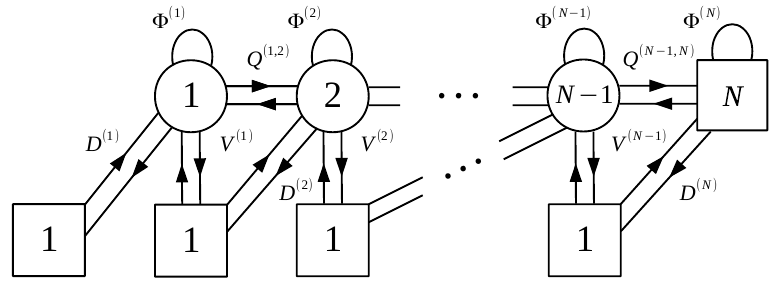
Figure 2 . Quiver diagram of the FM [SU( N )] theory. Double-lines connecting two nodes repre- sent pairs of bifundamental chirals in conjugate representations with respect to the corresponding symmetries. Lines that start and end on the same node correspond to chirals in the adjoint repre-